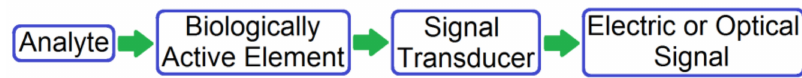
Figure 1. Schematic diagram representing the di ff erent components of a